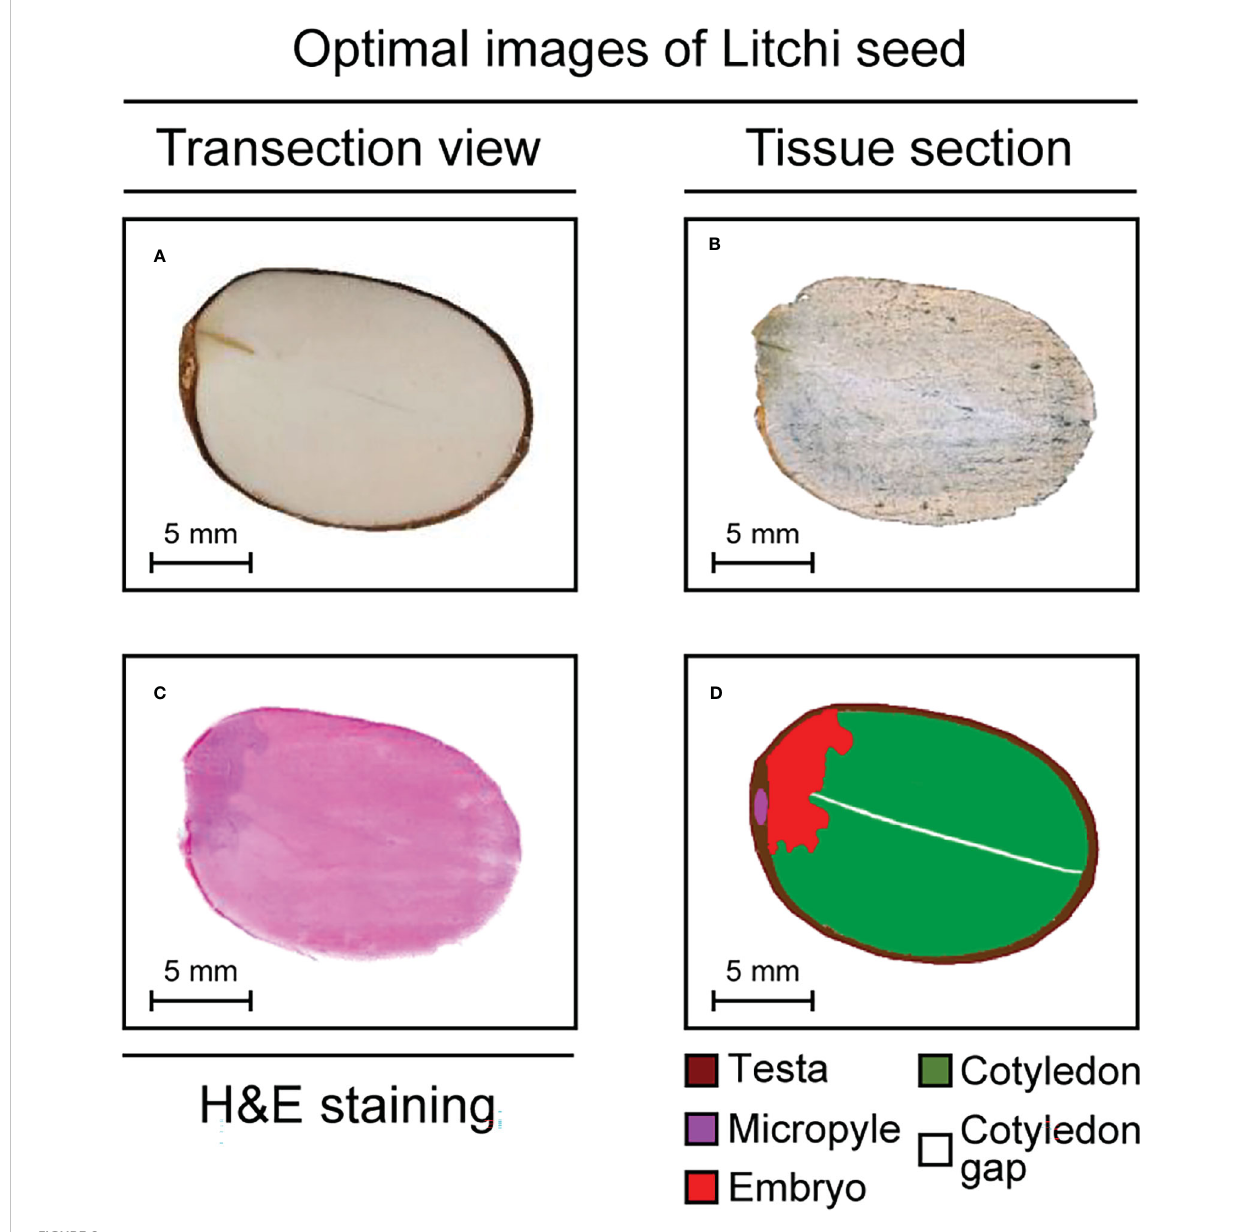
FIGURE 2 Optimal images of litchi seed tissue sections. (A, B) Photos of litchi seed tissue sections. (C) An H&E-stained litchi seed tissue section. (D) A cartoon of anatomical structure of litchi seed tissue section. H&E, hematoxylin and